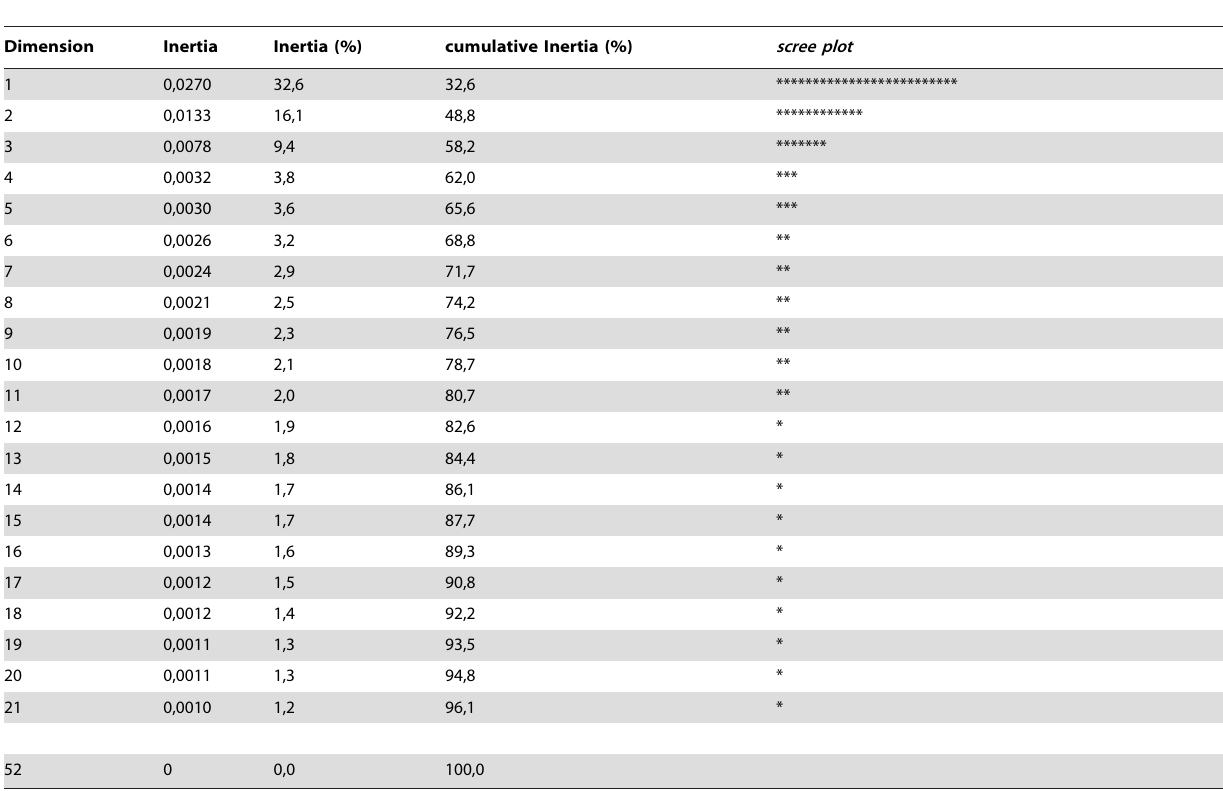
Table 1. Explained inertia by each dimension for group A: Indoor Index, 2007.